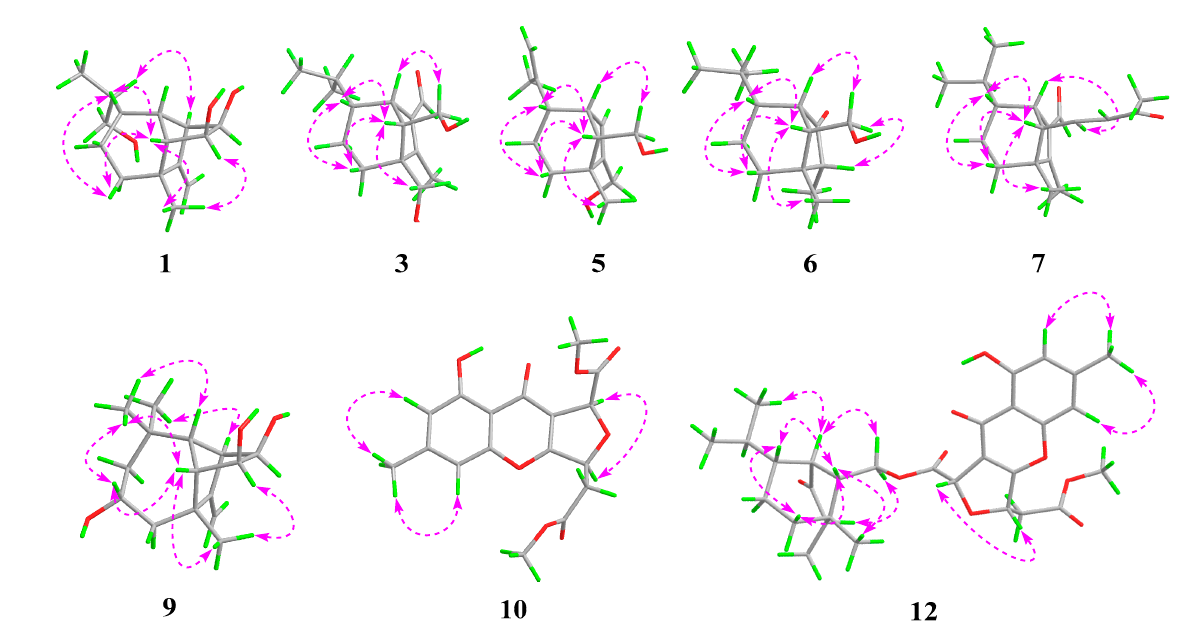
Figure 2. Key 1 H– 1 H COSY and HMBC correlations for 1 , 3 , 5 , 6 , 7 , and 9 – 13 .